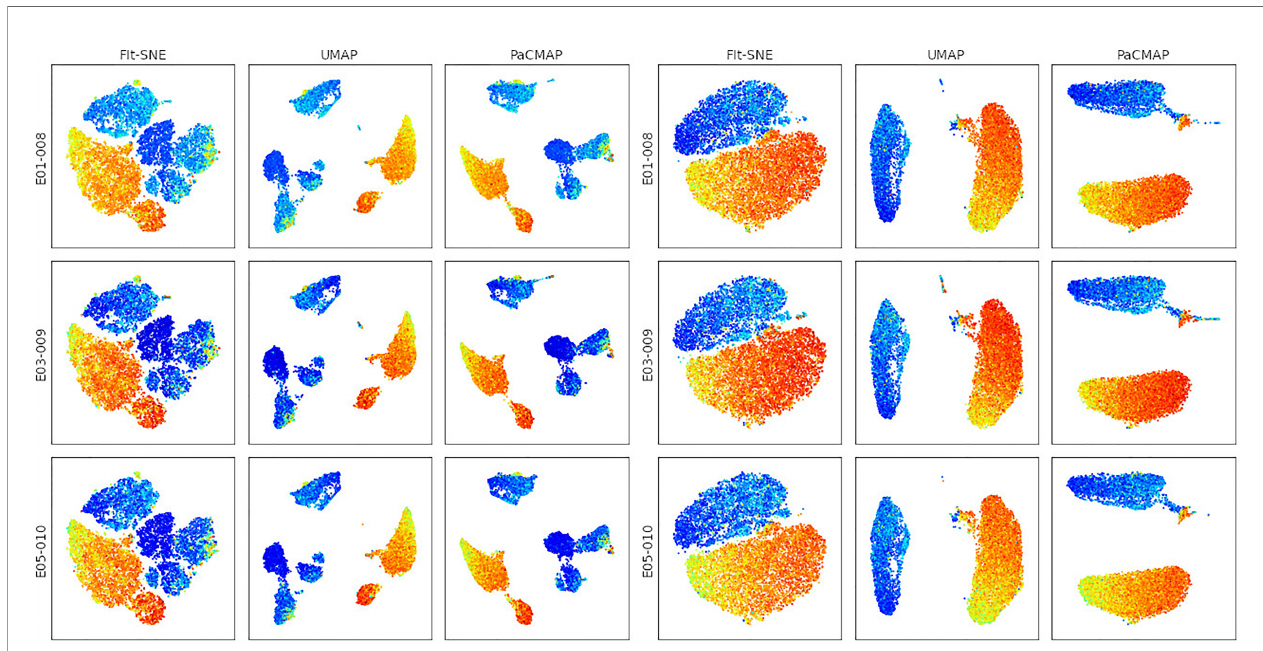
FIGURE 3 | Comparison of dimension reduction algorithms on the Singlets (left) and CD3+ (right) gated events. Events are pseudo-coloredby the CD4marker intensity.